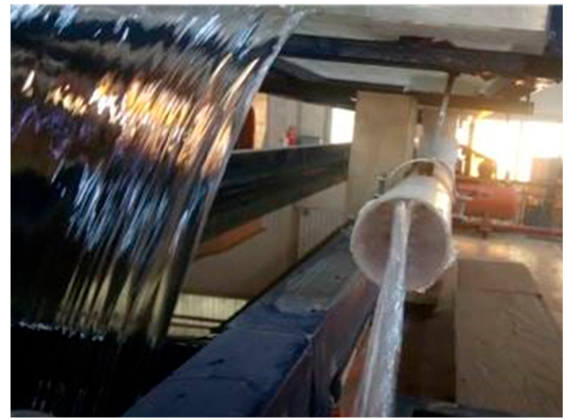
Figure 9. End pipe blockage with HB = 90%.